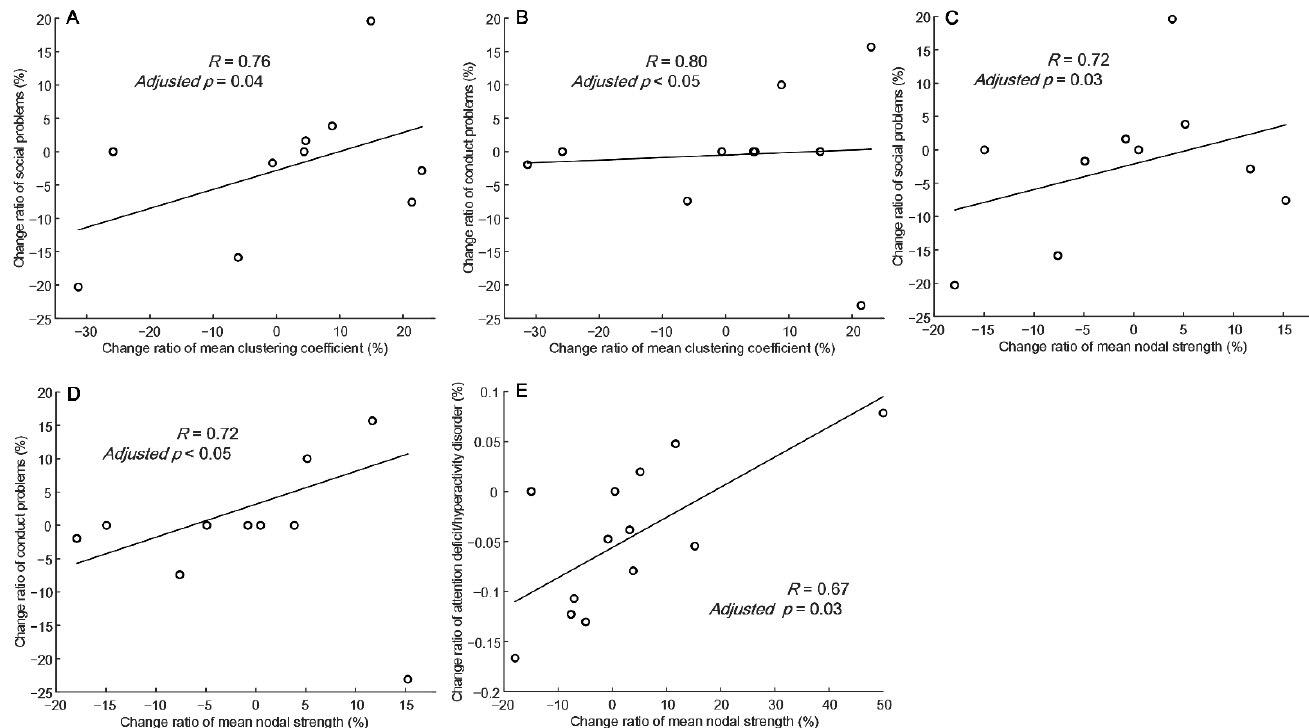
Figure 4. Correlation between the change rate of the mean clustering coefficient and the mean nodal strength in the delta frequency band versus the change rate of CBCL scores from the father ( A – D ) and mother ( E ).